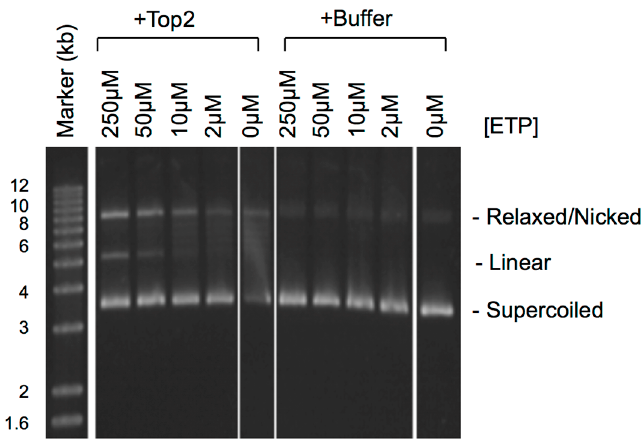
Figure 1. The effect of etoposide concentration on Top2cc trapping. The reactions (5 μ L) contain: pGT2 plasmid DNA (10 ng/ μ L), Top2 (1 unit/ μ L; USB, OH) or buffer and the indicated concentrations of etoposide (ETP) (Sigma, St. Louis, MO, USA) (the Top2 reactions also contained 1 mM ATP). After incubation at 37 °C for 10 min, the reactions were terminated with 1.5 μ L of 4% SDS + 50 mM EDTA and then treated with 7.5 µ L proteinase K (1 µ g/ µ L; Sigma, St. Louis, MO, USA) at room temperature for 2 h. The products were separated on a 1% TAE-agarose gel at 80 volts for 3 h and detected by